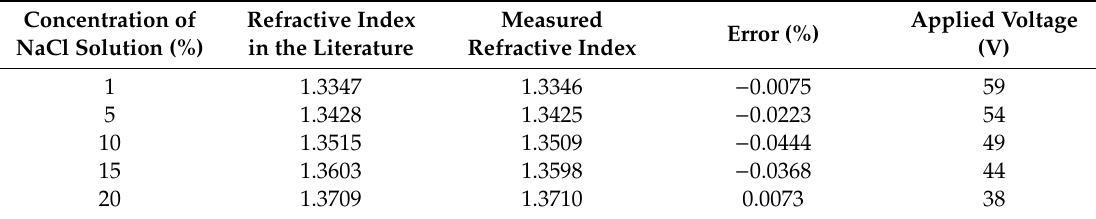
Table 1. Refractive index and error measurement with di ff erent concentrations of NaCl solution.